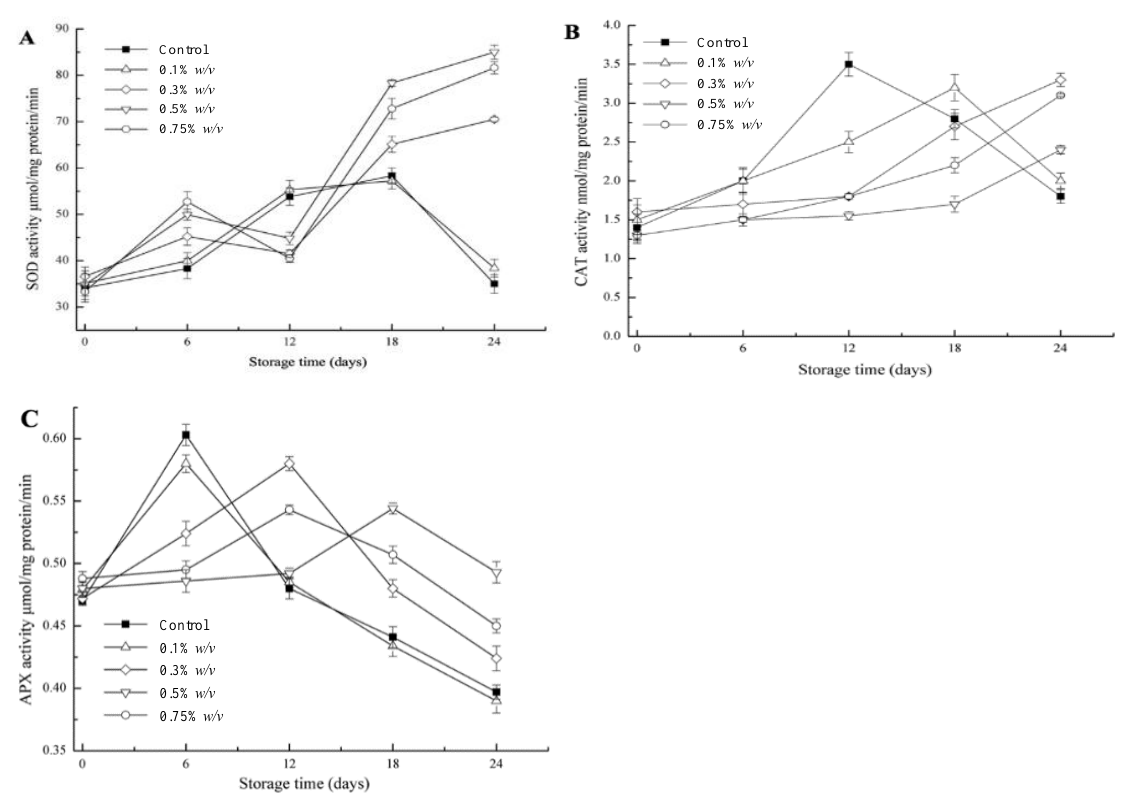
Figure 4. Change of SOD activity ( A ), CAT activity ( B ) and APX activity ( C ) in sweet cherry stored at 10 °C during storage time. The data are the means ± standard-deviation (SD).